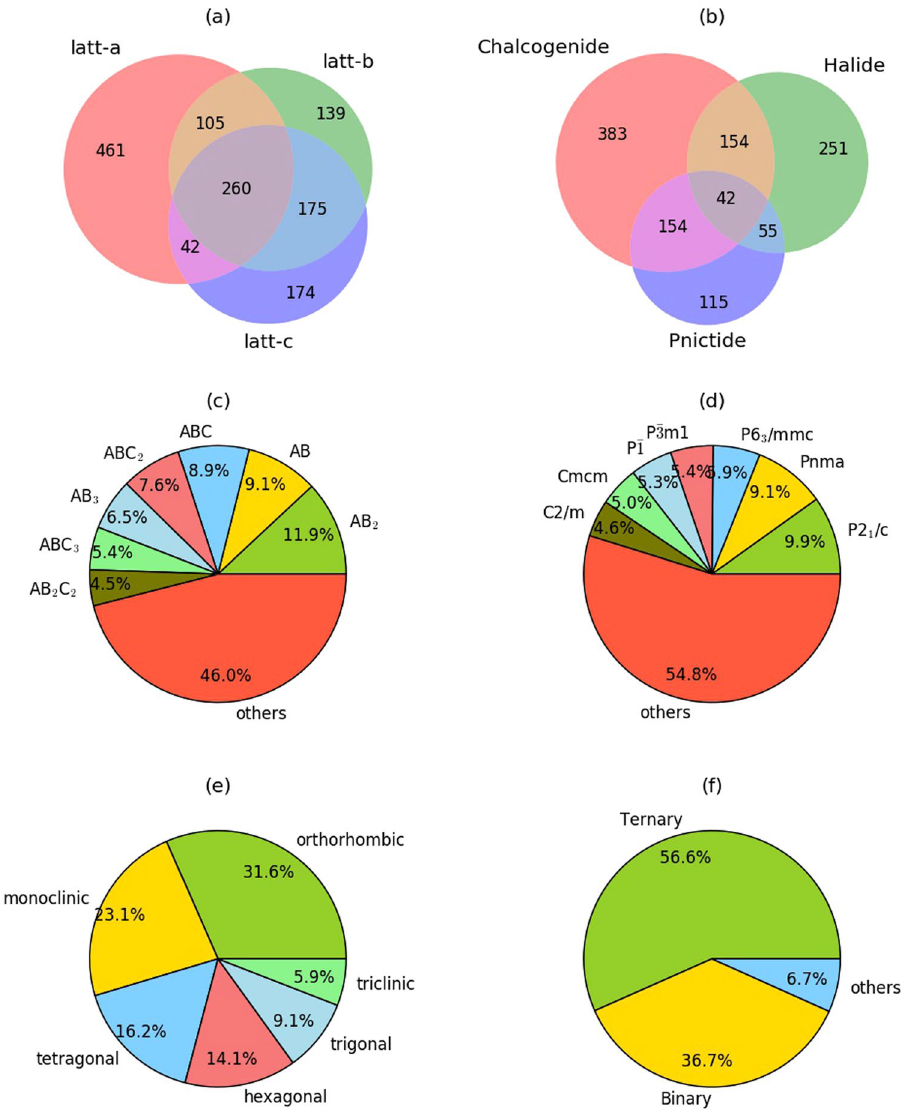
Figure 1. Classification of predicted layered materials in term of ( a ) relative error in lattice constants, ( b ) chemical compositions, ( c ) crystal prototypes, ( d ) crystal space group, ( e ) crystal-systems and ( f ) number of distinct chemical